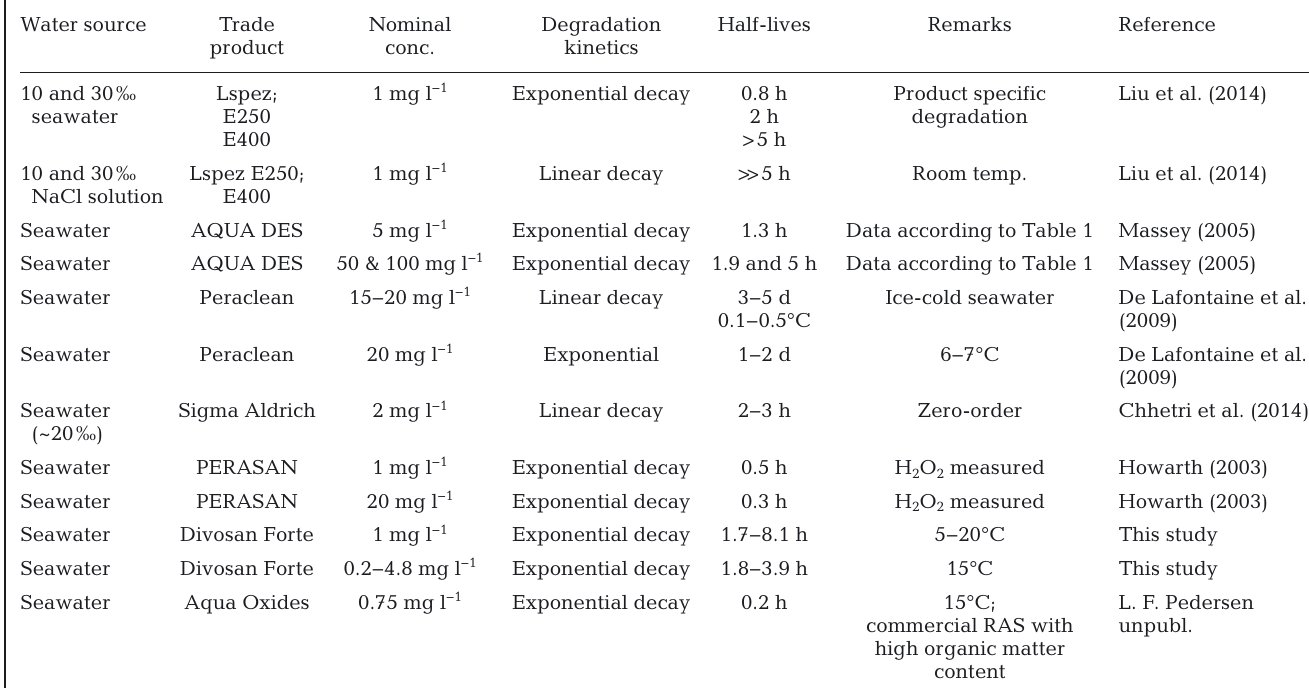
Table 1. Overview of studies on peracetic acid (PAA) decomposition in seawater. Supplementary studies of PAA decomposition in other water matrices can be found in Luukkonen & Pehkonen (2017). RAS: recirculating aquaculture